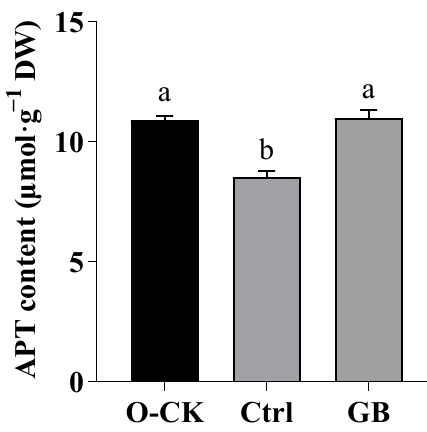
Figure 3. Effects of GB on ATP content in B. rapa under heat stress. Data are shown as mean ± SD. Different lowercase letters indicate significant difference at p < 0.05. O-CK, optimum conditions, foliar sprayed with water; Ctrl, foliar sprayed with water before exposure to heat stress; GB, foliar sprayed with GB before exposure to heat stress.